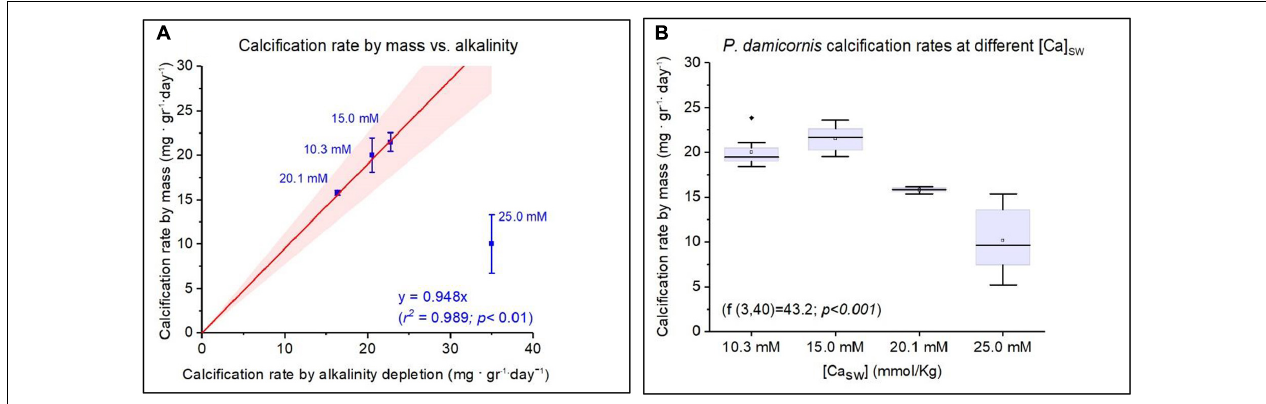
FIGURE 2 | Calcification rates of Pocillopora damicornis under variable Ca SW . (A) Calcification rate measured by mass addition compared to alkalinity depletion. Corals cultured under Ca SW of 25 mM are excluded from the regression due to mortality on 28th day. (B) The Mean, median, and deviations of growth rate as a function of Ca SW with maximum values showed at 15 mM (21.5 ± 1.05 mg. gr − 1 . day − 1